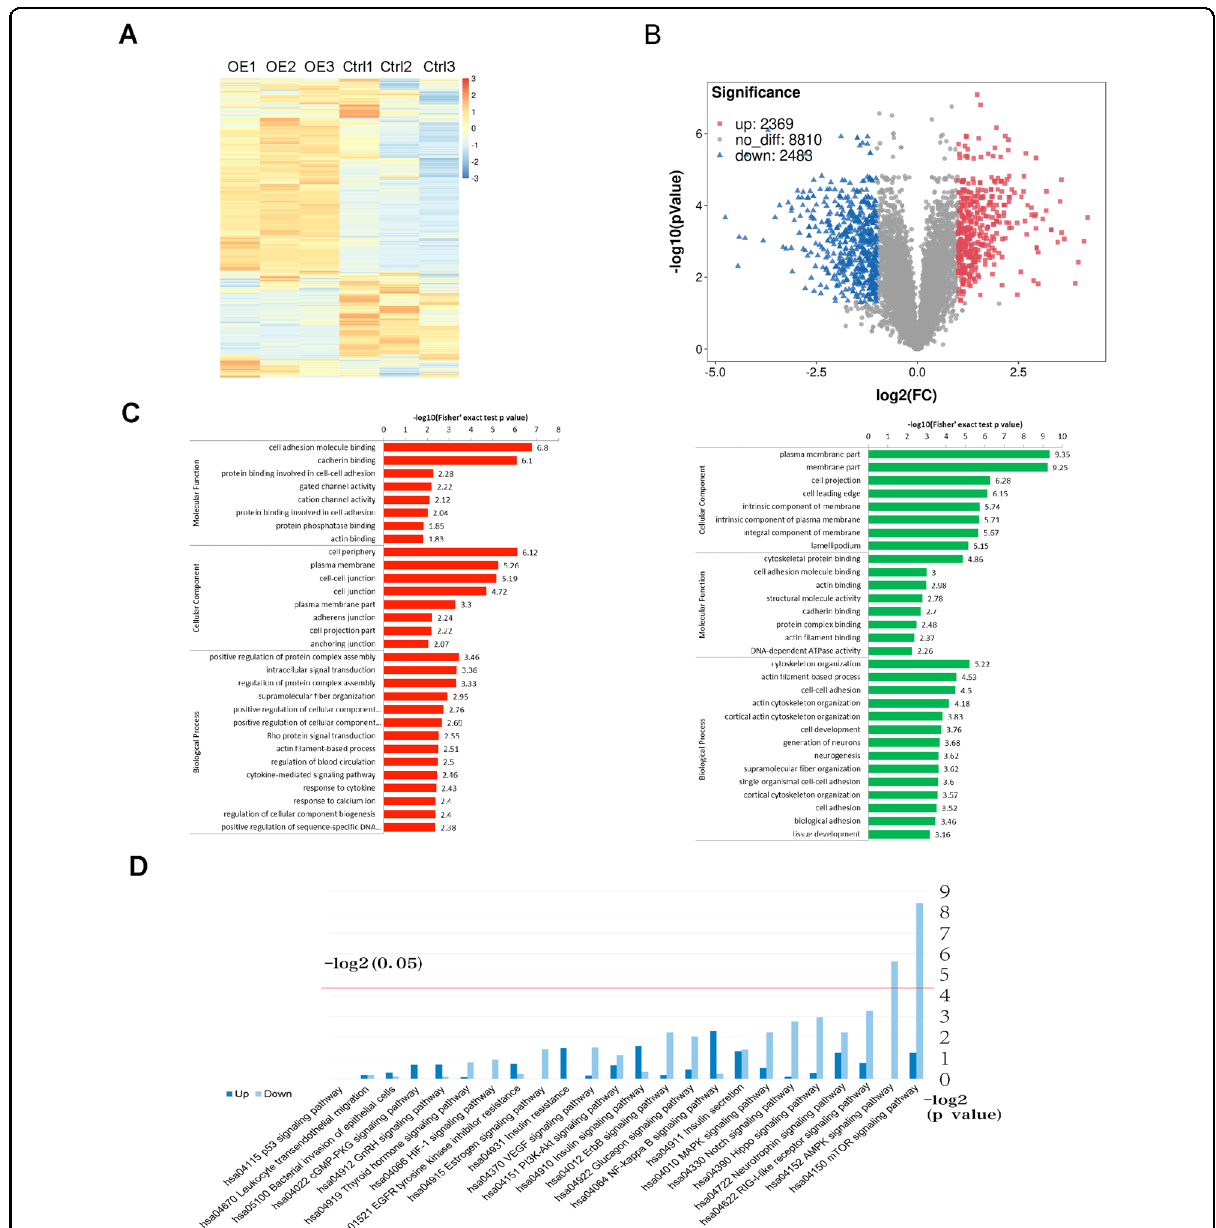
Fig. 3 GOLM1-overexpression induced changes in large-scale quanti fi cation of the phosphoproteomics. A Heatmap of expression levels of differentially phosphorylation modi fi ed sites summary between empty vector PC9 cell line and GOLM1 overexpression PC9 cell line. B Volcano map of differentially expressed phosphorylating sites between empty vector PC9 cell line and GOLM1 overexpression PC9 cell line (UP refers to proteins with increased phosphorylation in GOLM1OE cells; down refers to proteins with decreased phosphorylation in GOLM1OE cells). C GO enrichment results of corresponding proteins at upregulated sites and downregulated sites between empty vector PC9 cell line and GOLM1 overexpression PC9 cell line (left refers to upregulated phosphorylation sites; right refers to downregulated phosphorylation sites). The horizontal axis value is the negative logarithmic conversion of signi fi cant P value ( P < 0.05). D The KEGG enrichment analysis showed the top 24 signaling